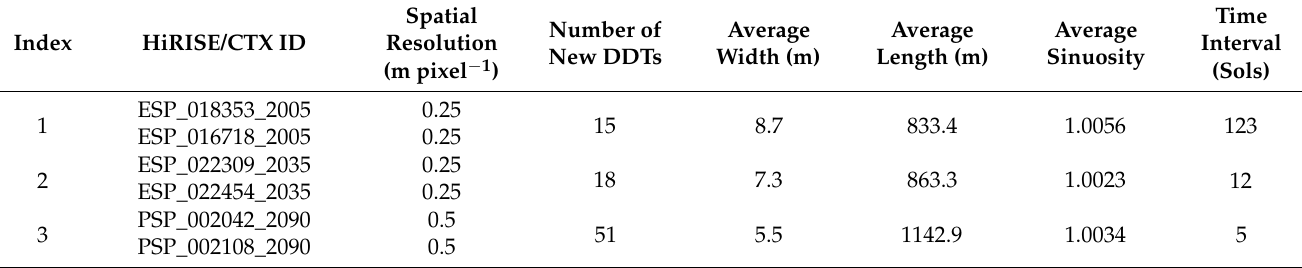
Table 1. Summary of DDT measurements in 12 image pairs. The image pair index is consistent with that in Figure 2.